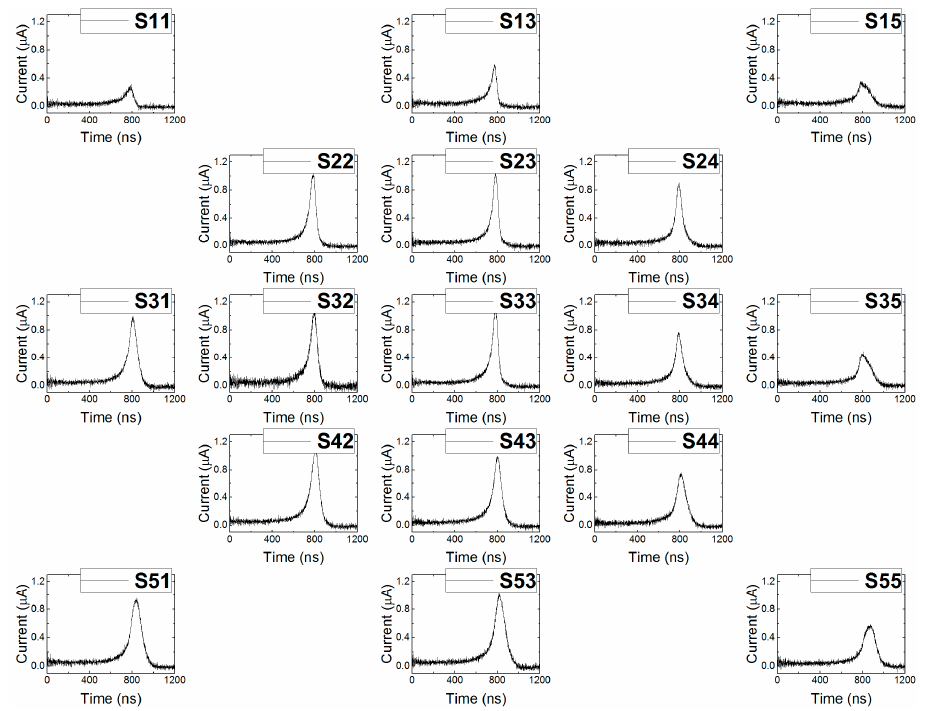
Figure 9. Current waveforms measured on CP at 400 V bias while illuminating different spots.